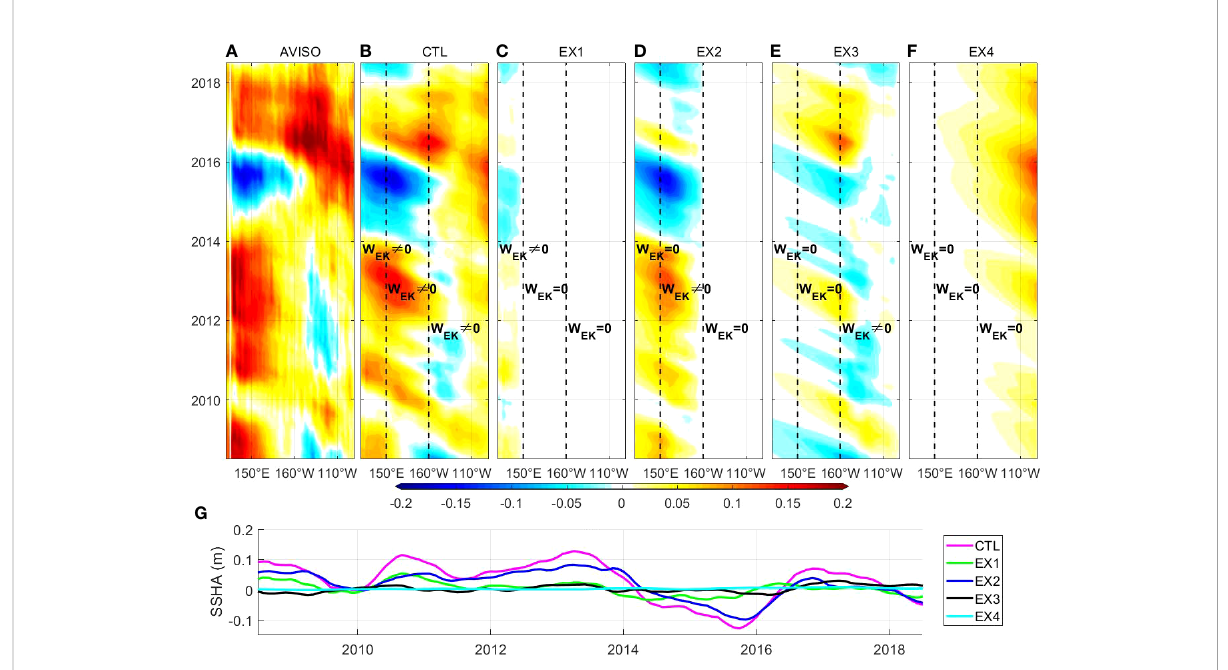
FIGURE 8 Hovmöller diagrams of SSHA (m) at 8.5°N derived from (A) altimeter observation and (B – F) model experiments with period longer than a year. (B) is forced by the wind stress curl from 130°E to 90°W and eastern boundary forcing. (C – E) are only forced by the wind stress curl